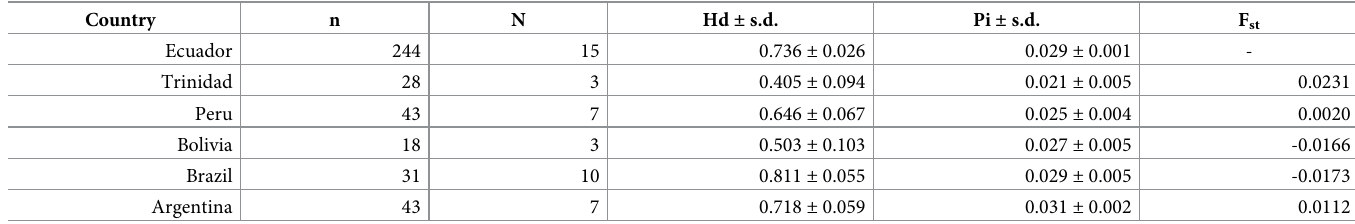
Table 3. Genetic variability analysis for the TpiI4 segment for fall armyworm from different locations. Metrics include number of sequences analyzed (n), number of haplotypes (N), haplotype diversity (Hd ± standard deviation [s.d.]), nucleotide diversity (Pi ± s.d.), and fixation index (F st ) measured in pair-wise comparison with Ecua- dor populations. N Hd ± s.d.